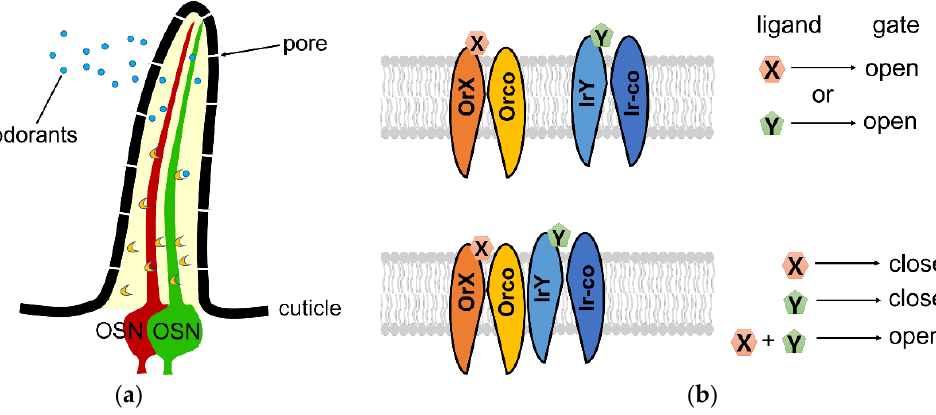
Figure 1. Olfactory receptor organization in insects and tuning models. ( a ) Olfactory organs of Drosophila are covered by sensilla. Each sensillum contains one to four olfactory neurons (OSNs); neurons are shown in red and green. ( b ) Expressing more than one receptor in one neuron leads to ‘or’ gate (top panel) or ‘and’ gate (bottom panel) potential model.